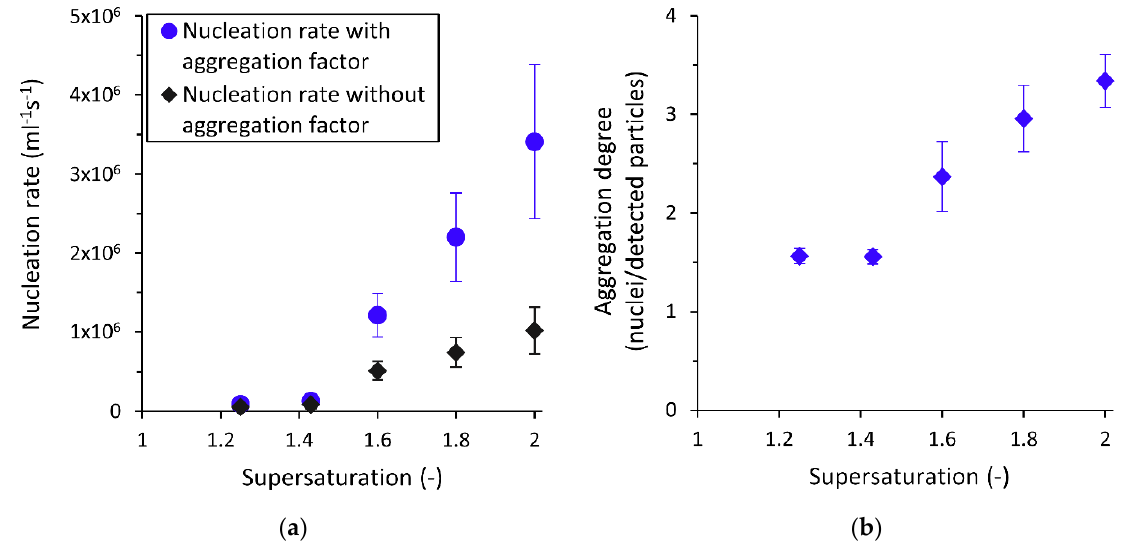
Figure 5. Influence of the supersaturation on ( a ) the nucleation rate, and ( b ) the aggregation